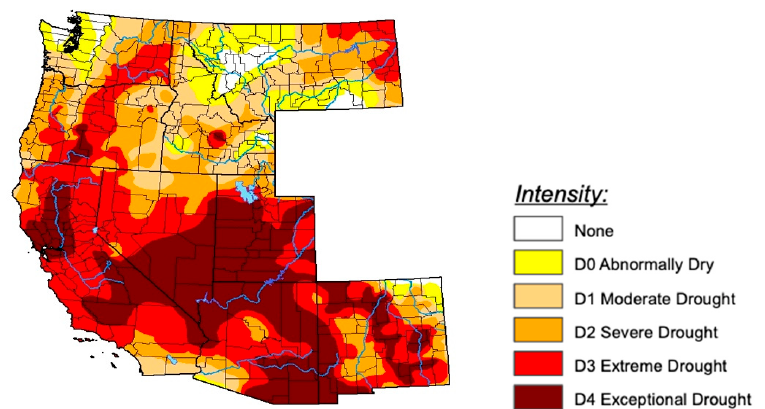
Figure 1. U.S. Drought Information. Source: Fusch, 2021, https://droughtmonitor.unl.edu/data/ pdf/20210608/20210608_west_text.pdf (accessed on 15 January 2021). The U.S. Drought Monitor is jointly pro- duced by the National Drought Mitigation Center at the University of Nebraska-Lincoln, the United States Department of Agriculture, and the National Oceanic and Atmospheric Administra- tion. Map courtesy of NDMC.